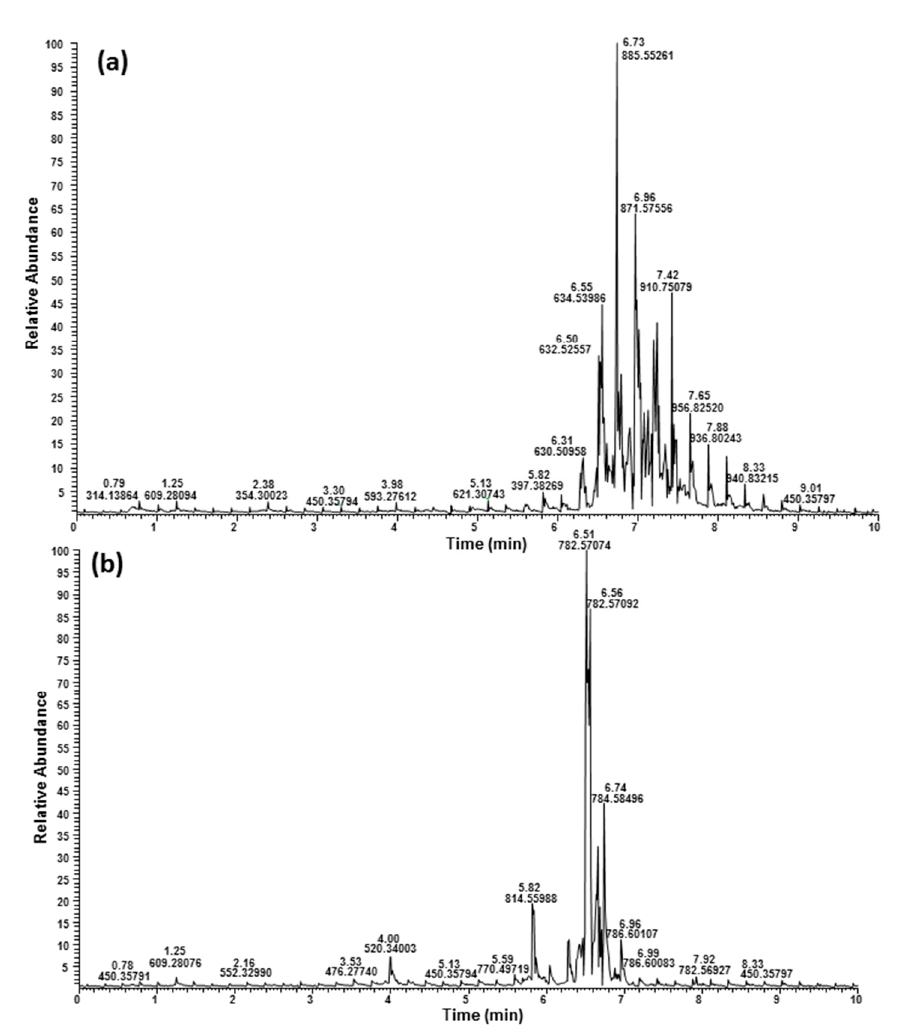
Figure 2. TICs of hemp seed hull SPE fractions acetone ( a ) and MeOH ( b ) in positive mode.